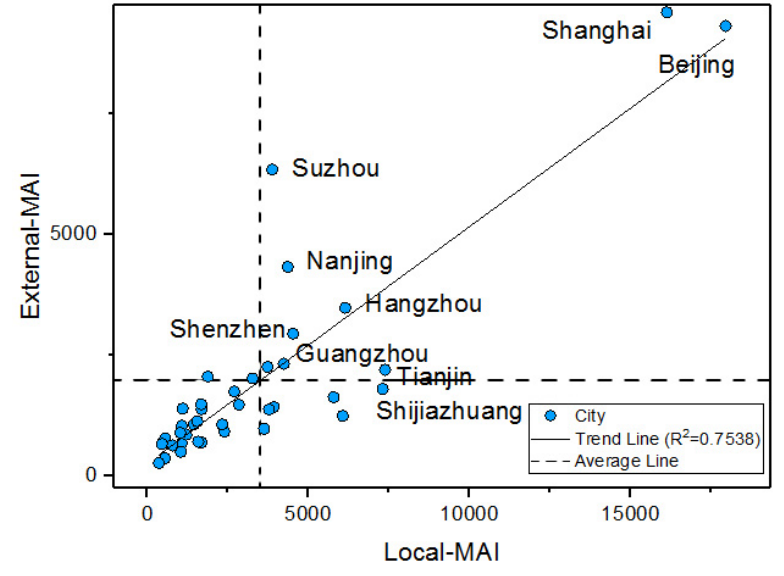
Figure 6. Scatter plot of external-MAI and Local-MAI.